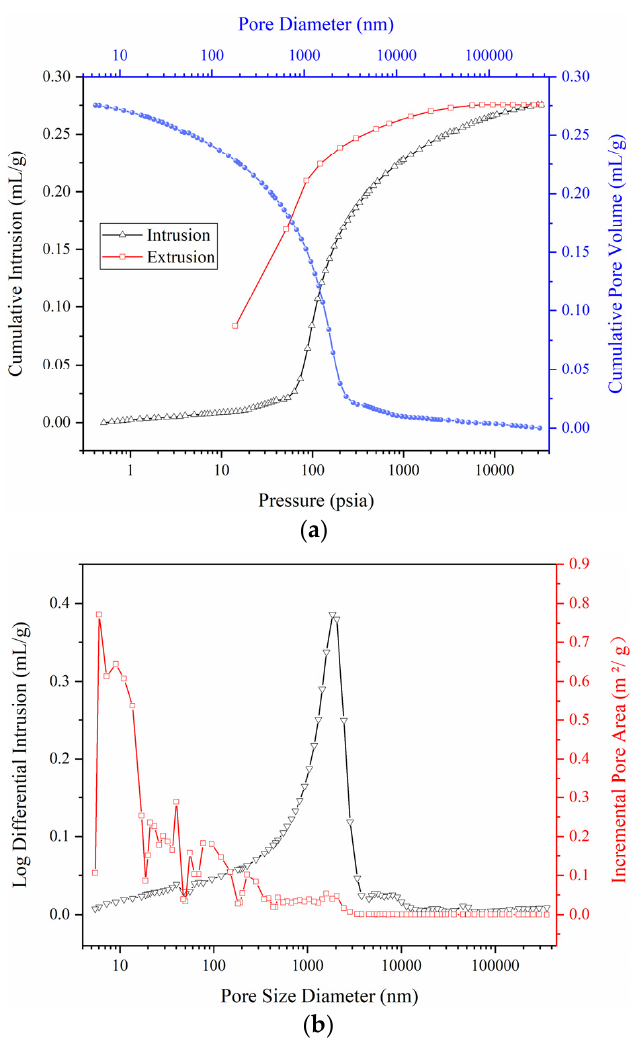
Figure 10. MIP Test Results. ( a ) Mercury injection-removal curve and cumulative-pore-volume curve. ( b ) Log-differential-intrusion curve and incremental-pore-area curve. ( b ) Log-differential-intrusion curve and incremental-pore-area